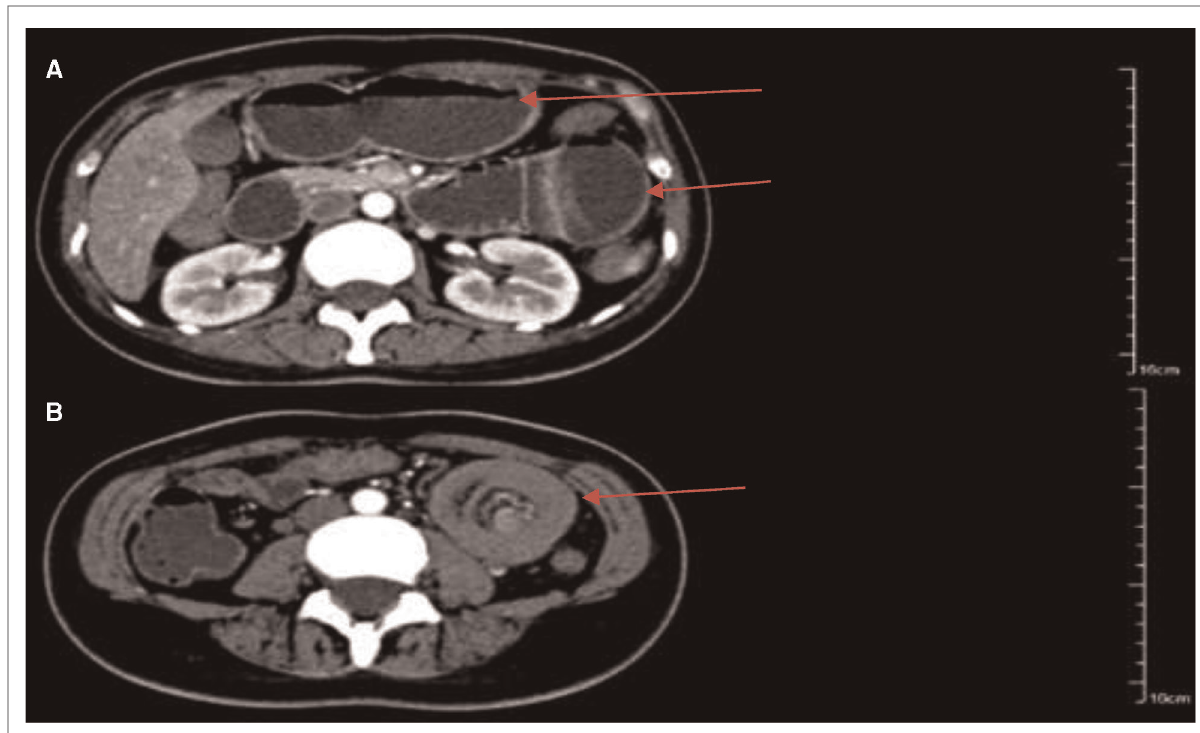
FIGURE 1 Arterial phase of abdominal contrast-enhanced computed tomography showed jejunal intussusception of the left-sided upper abdomen with concentric circle-like changes. ( A ) The intestinal canal of the upstream small intestine was dilated, and the outer intestinal wall was edematous and thickened (arrows); ( B ) there was the presence of the blood vessels and part of the mesenteric fat within a loop of jejunum which suggested intussusception with the jejunal lesion